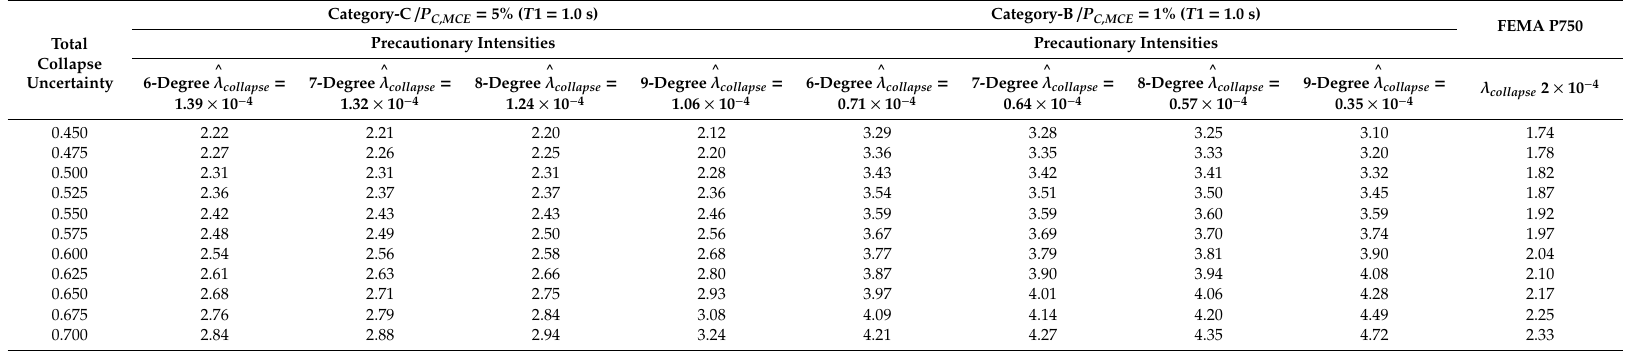
Table 1. Acceptable CMR s under di ff erent seismic precautionary. intensities of China and FEMA P750 [33]. Total Collapse